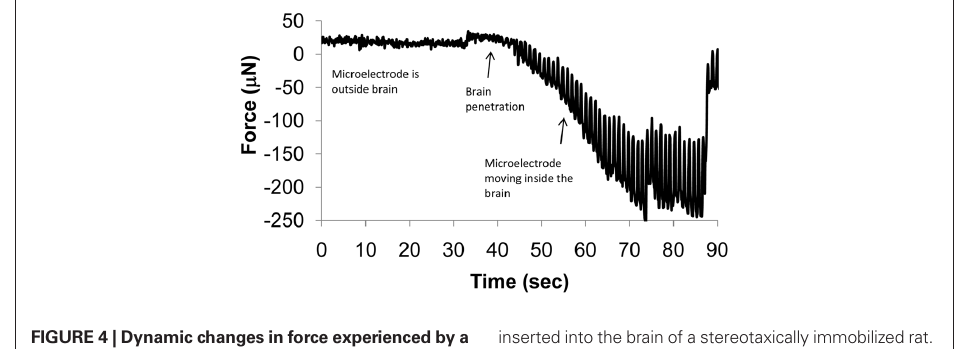
FigurE 4 | Dynamic changes in force experienced by a 200-μm diameter stainless steel microelectrode with a sharp taper as it penetrates the brain. The microneedle was mounted on a sensitive tension/ compression load cell attached to a micromanipulator and